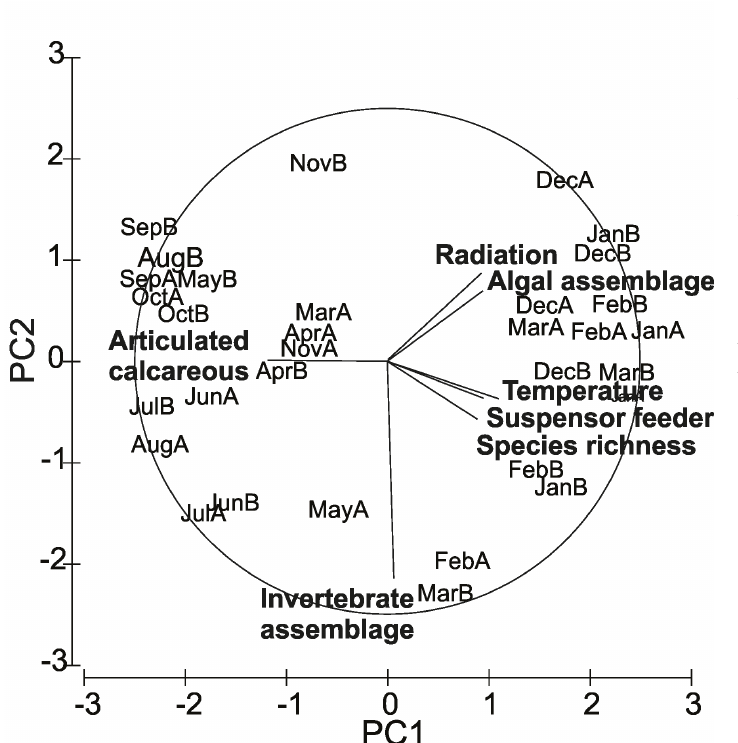
Figure 10. PCA biplot: association between biological and environmental variables. Biological variables: species richness, algal and invertebrate assemblages, suspensor and articulated calcareous groups. Environmental variables: seawater temperature and radiation. Months sampled were indicated by abbreviations: